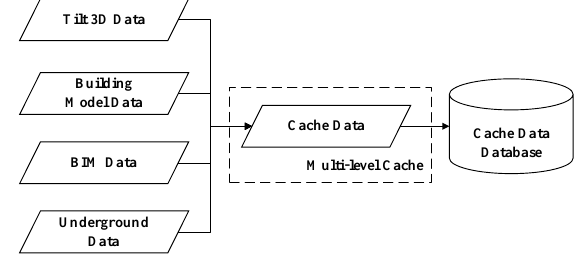
Figure 2 . The Composition of Database System